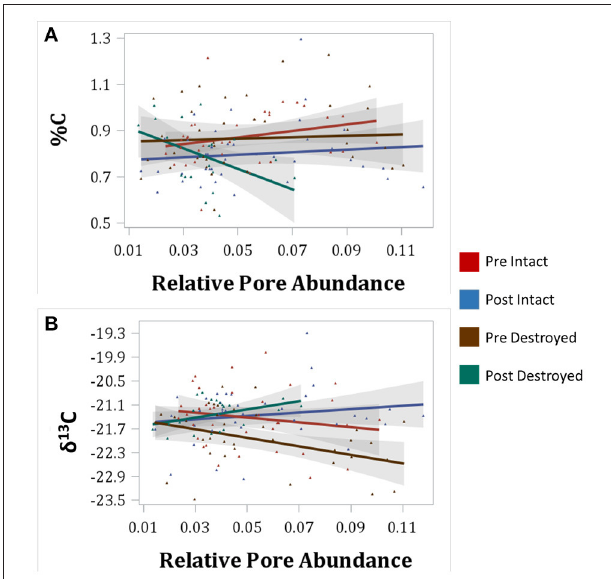
FIGURE 4 | Correlations between total C (%C) and relative abundances of 40–95 µ m pores (A) and between δ 13 C and 40–90 µ m pores (B) for intact-structure treatment and destroyed-structure treatment for both Pre and Post. Relative pore abundances refer to the percent of medial axes per total soil volume as determined from 3DMA-Rock software. Gray area indicates 95% confidence interval. Correlation coefficients are shown in Table 3 .